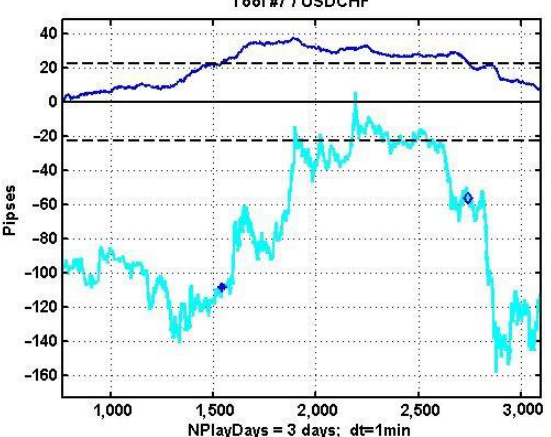
Figure 11. An example implementation of the simplest control strategy with an adaptive MR oscil-